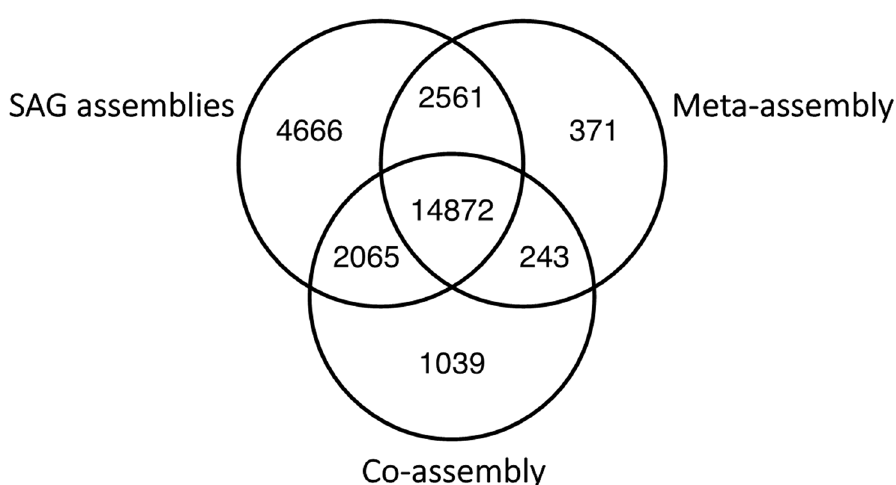
Figure 2. Comparison of the transcripts mapping to the assemblies. Venn diagram (drawn using the systemPipeR package 41 in R) showing the similarities and differences of the A. acetabulum transcripts mapping to the individual SAG assemblies (transcripts mapping to the five SAG assemblies are combined), Meta- assembly, and